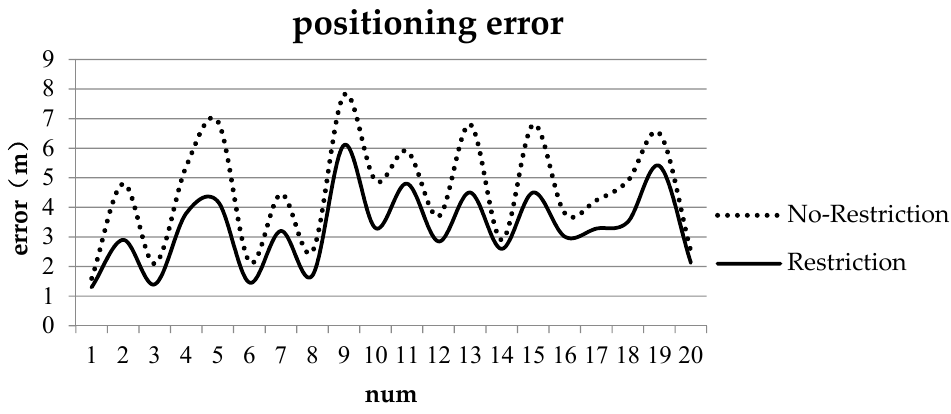
Figure 15. Positioning errors with two ROs: the dashed line indicates positioning errors with no restriction, and the solid line indicates positioning errors with restriction.